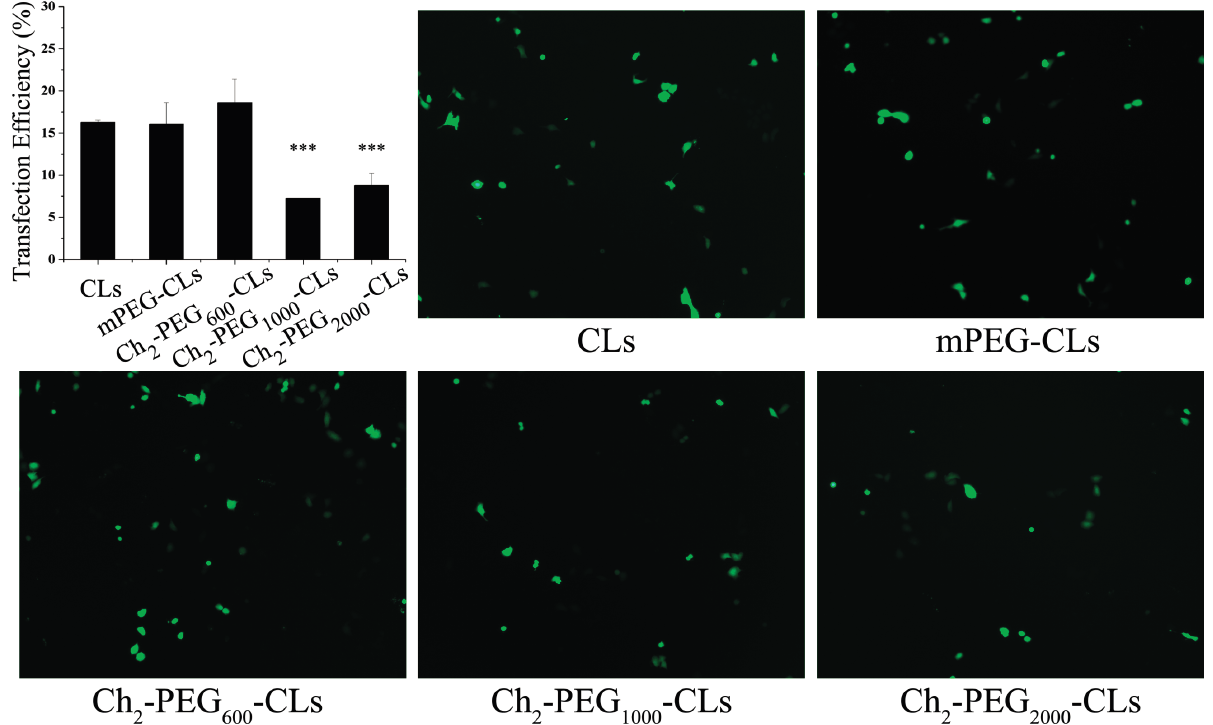
Figure 3. Transfection efficiency and fluorescence images (200×) of Ch 2 -PEG n -CLs (mean ± SD, n = 3, *** p <